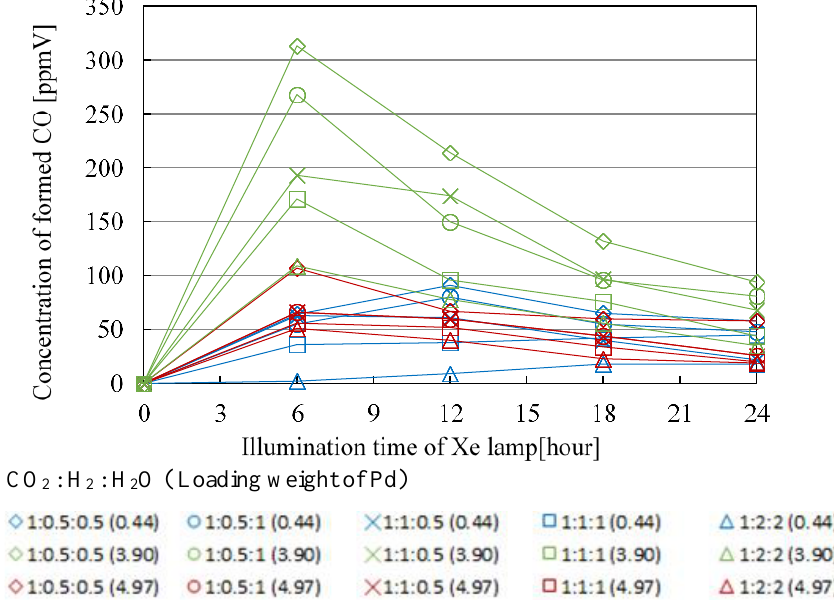
Figure 7. Change in concentration of formed CO with the illumination time among different molar ratios of CO 2 /H 2 /H 2 O and Pd loading weight with ultraviolet (UV) light illumination.